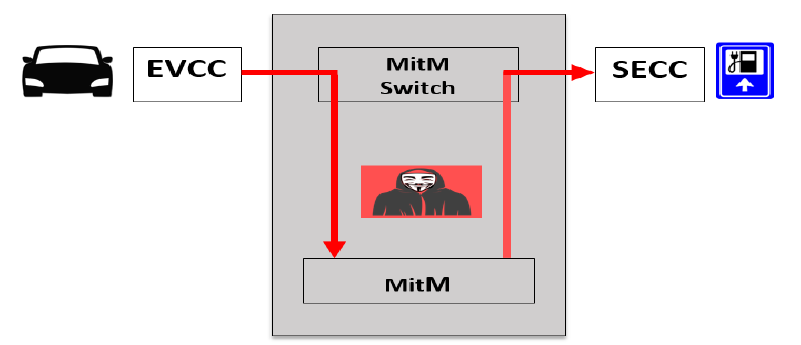
Figure 2. Architecture relating to the simulation of the MitM-type